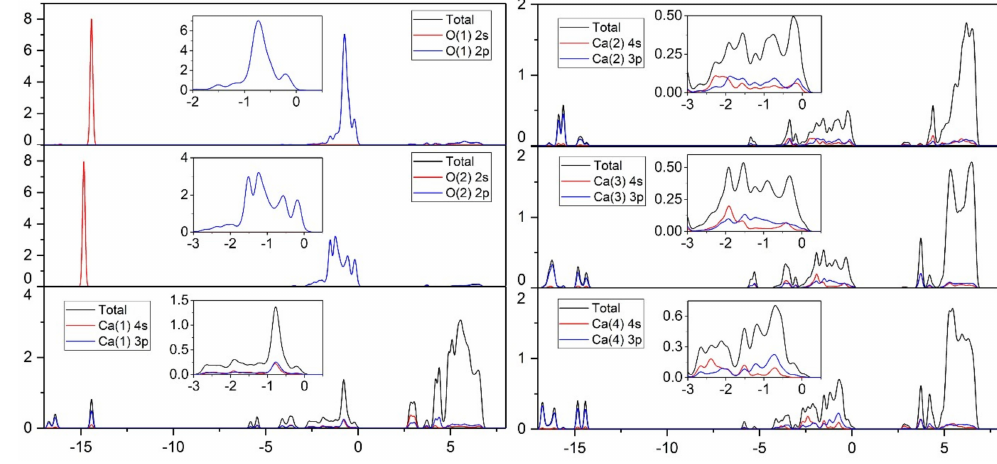
Figure 4. Partial density of states for surface O and Ca atoms.